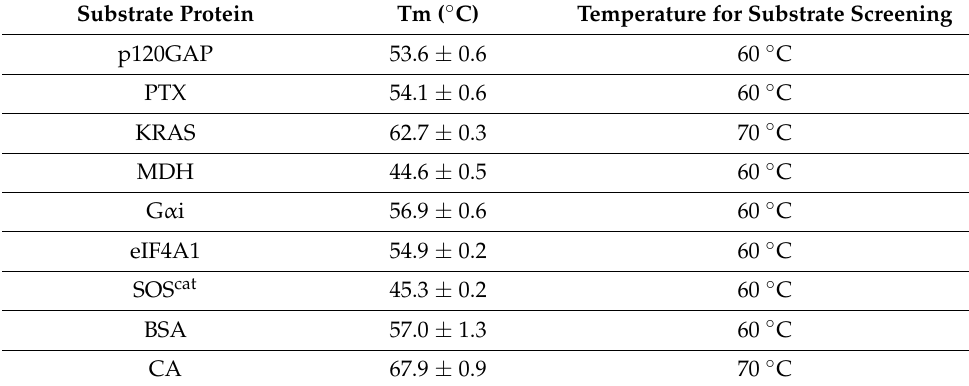
Table 1. Temperatures were selected for substrate screening based on the denaturation temperatures of these substrate